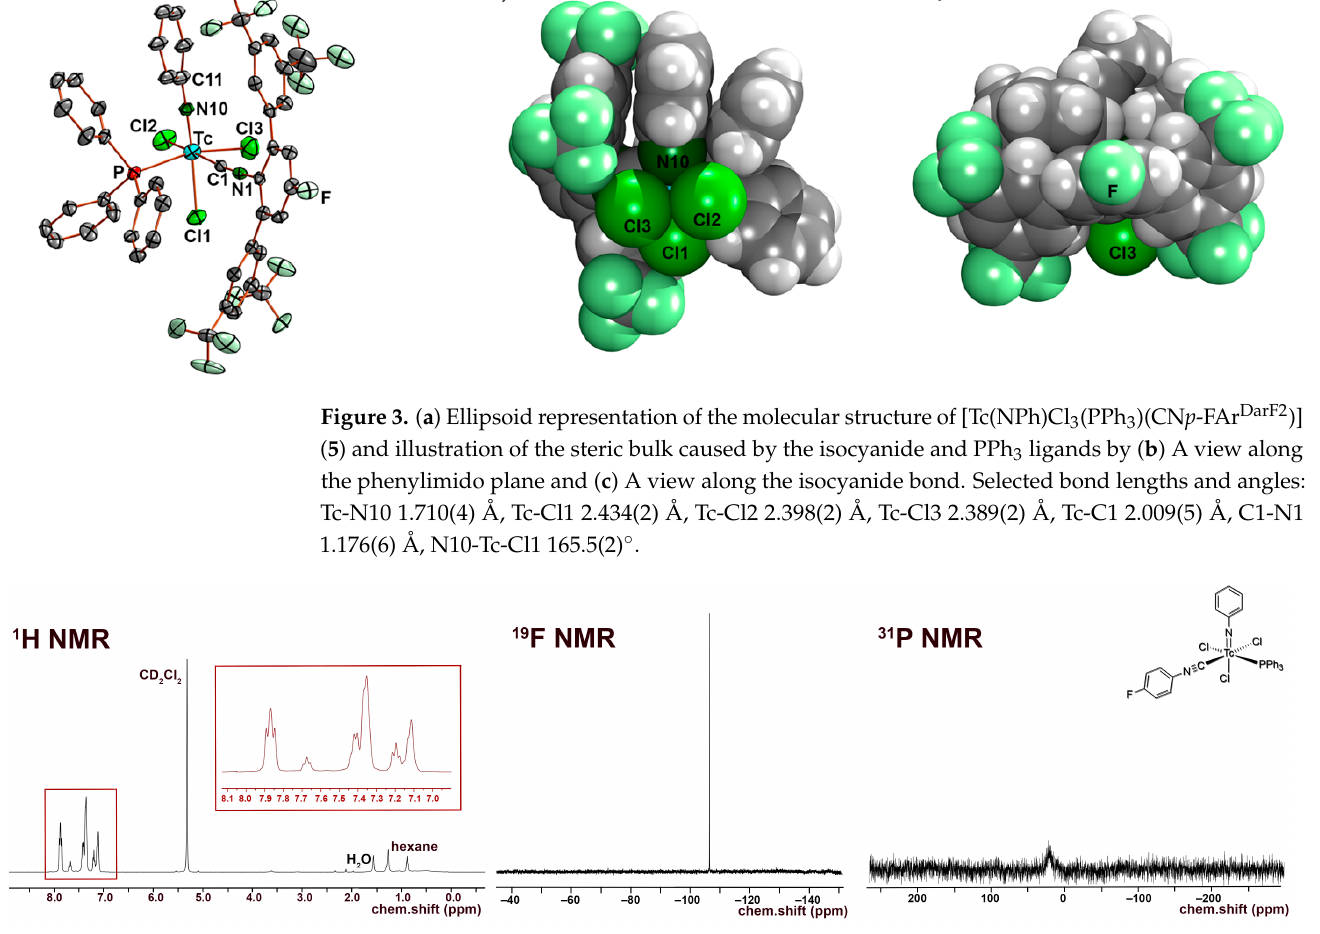
Figure 4. 1 H, 19 F and 31 P NMR spectra of [Tc(NPh)Cl 3 (PPh 3 )(CNPh pF )] ( 6 ) in CD 2 Cl 2 .